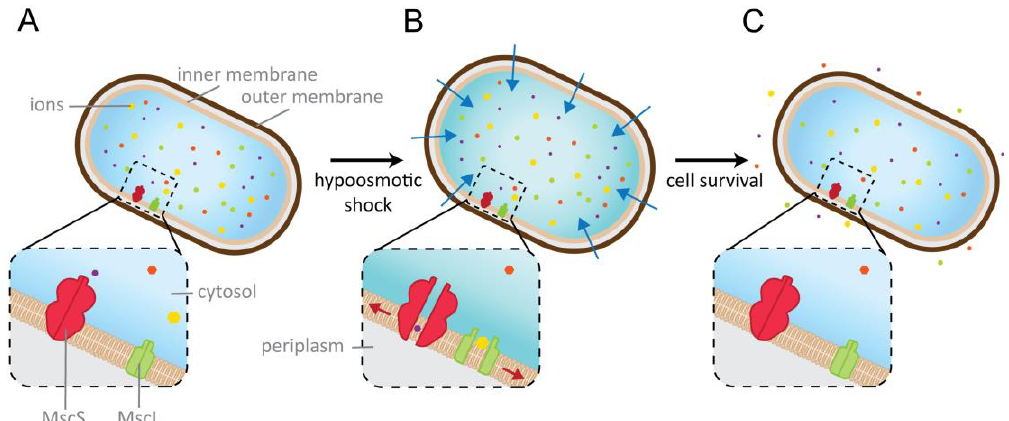
Figure 1. Physiological role of mechanosensitive channels in prokaryotes. ( A ) The bacterial MS channels MscS and MscL are located in the inner membrane and play an essential role for the osmoregulation of the cell. ( B ) A rapid drop of the osmolarity of the environment leads to water influx (blue arrows) that increases the turgor and, as a result, the membrane tension (red arrows). MscS and MscL sense these elevated membrane tension levels and open transiently to release osmolytically active solutes. ( C ) When the osmotic balance is restored, the channels close again.